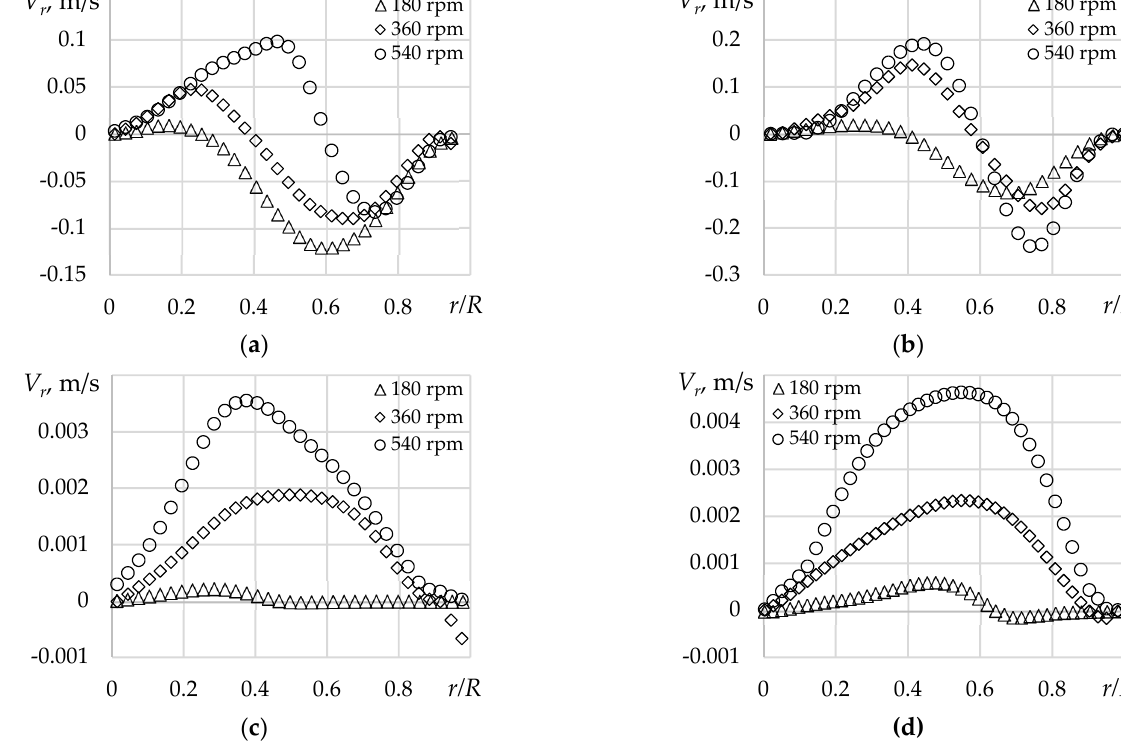
Figure 8. The radial velocity profiles in air ( a ) at h = 0.5, ( b ) at h = 0.8, and in glycerol ( c ) at h = 0.5 and ( d ) at h = 0.8.